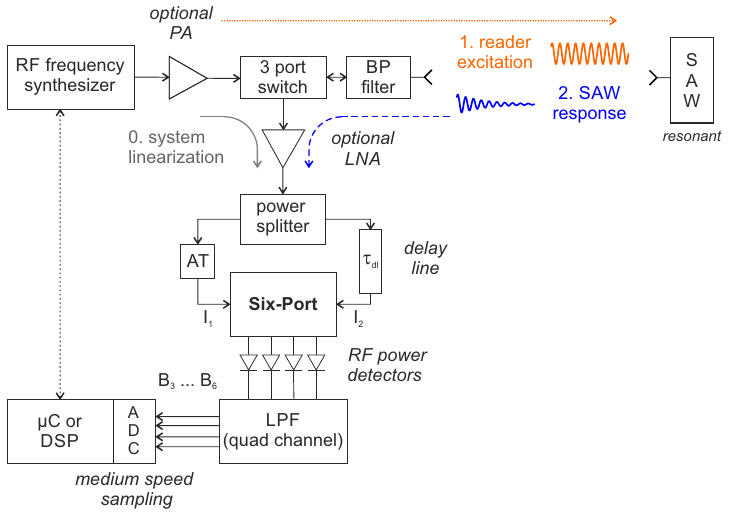
Figure 10. Block diagram of the reader concept for time domain sampling with instantaneous frequency measurement.